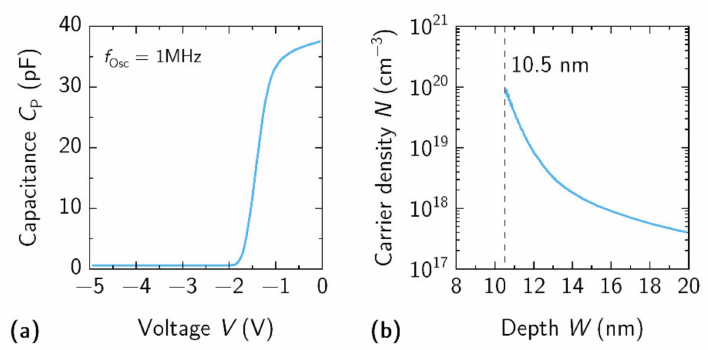
Figure 5. ( a ) Capacitance-voltage (at 1 MHz) measurements for circular SBD with Ø80 µ m inner Schottky contact pad which is separated from outer ohmic contact by 5 µ m. ( b ) Measured distribution of carrier density in the heterostructure. The position of 2DEG was found at 10.5 nm as marked by dashed vertical line.